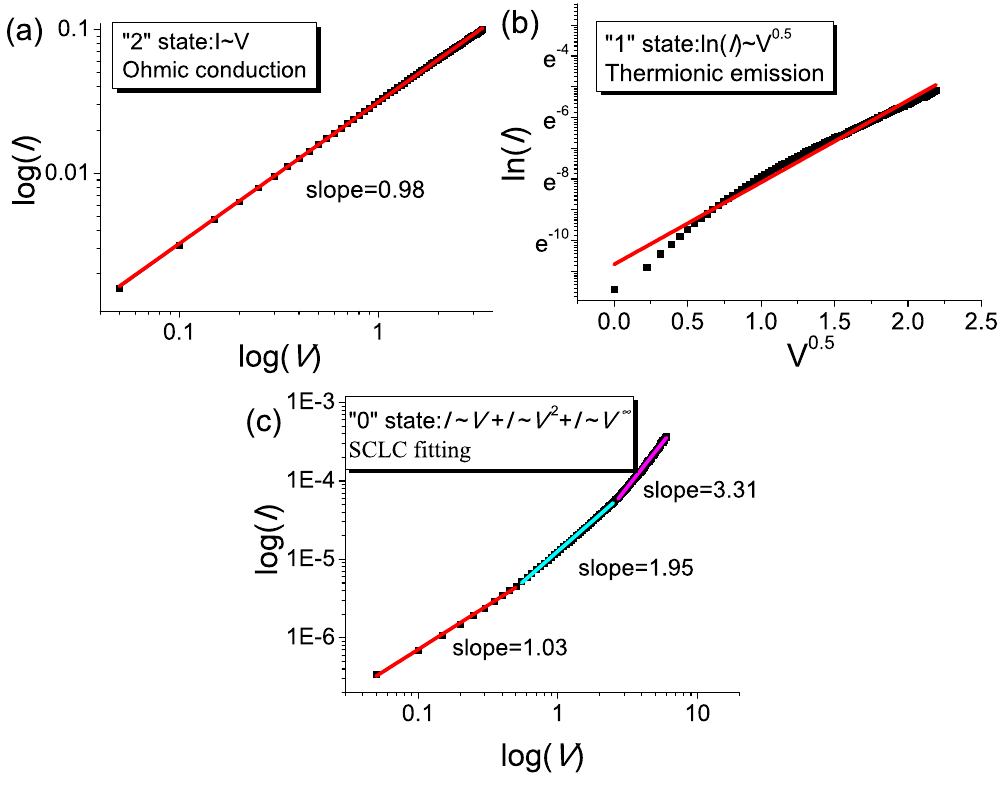
Figure 5. Analysis of I - V characteristics for the ITO/PS + GO/Al device: ( a ) Ohmic conduction behavior in the “2” state; ( b ) thermionic emission in the “1” state; ( c ) SCLC model in the “0”